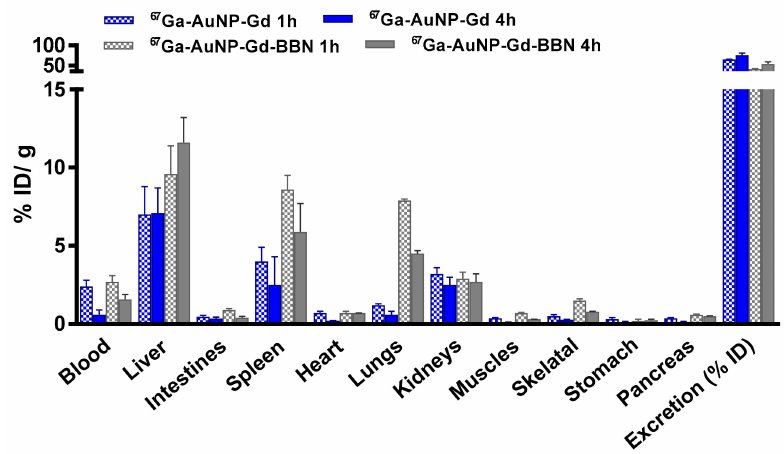
Figure 4. Biodistribution of 67 Ga-AuNP-Gd and 67 Ga-AuNP-Gd-BBN in CD1 mice, 1 h and 4 h after intravenous administration. Results are expressed as mean ± SD (n = 3).